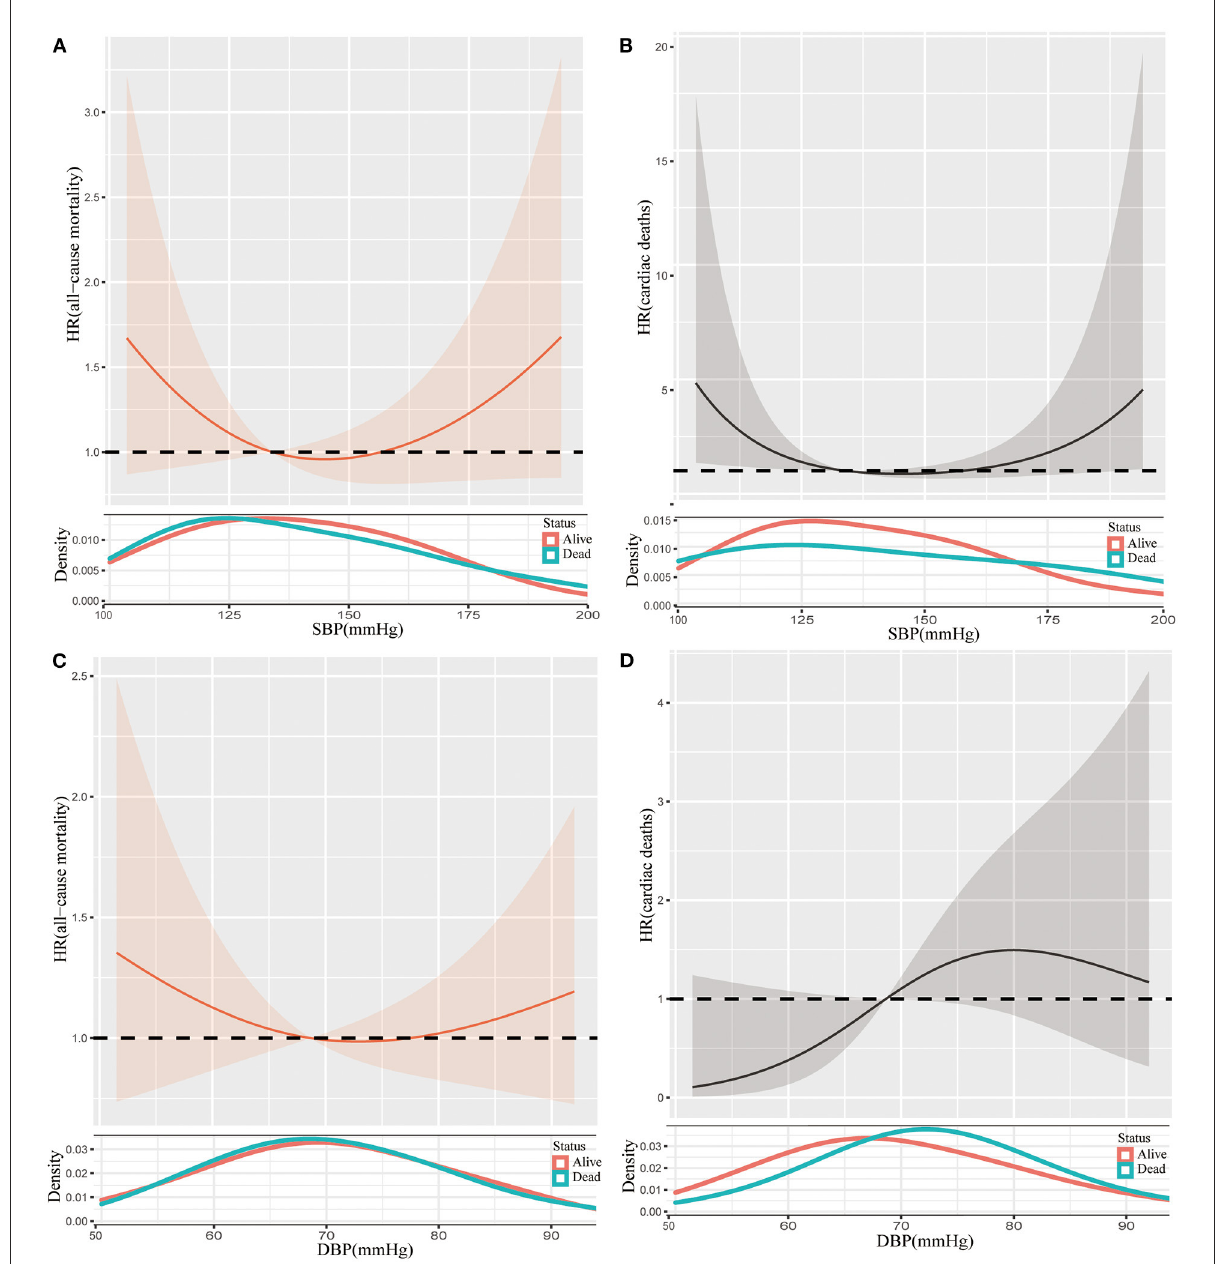
FIGURE4 Restricted cubic spline plots of the association between SBP and all-cause mortality (A) , SBP and cardiac death (B) , DBP and all-cause mortality (C) , and DBP and cardiac death (D) in frail participants. Analysis was adjusted for age, gender, race, diabetes, stroke, coronary artery disease, smoker, antihypertensive medication. SBP, systolic blood pressure; DBP, diastolic blood pressure; HR, hazard